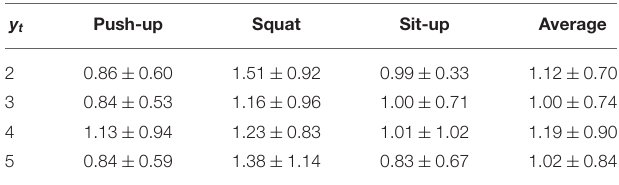
TABLE 5 | MAE of each type of workout for WeakCounterF (one-shot) fine-tuned on a weakly labeled segment with label y t . y t Push-up